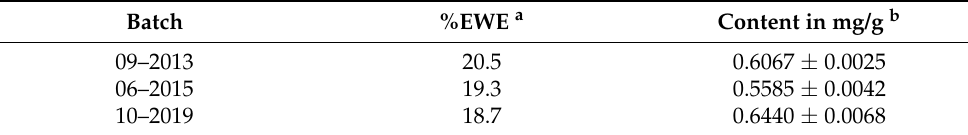
Table 3. Content of rutin ( 6 ) in C. guatemalensis . Batch %EWE a